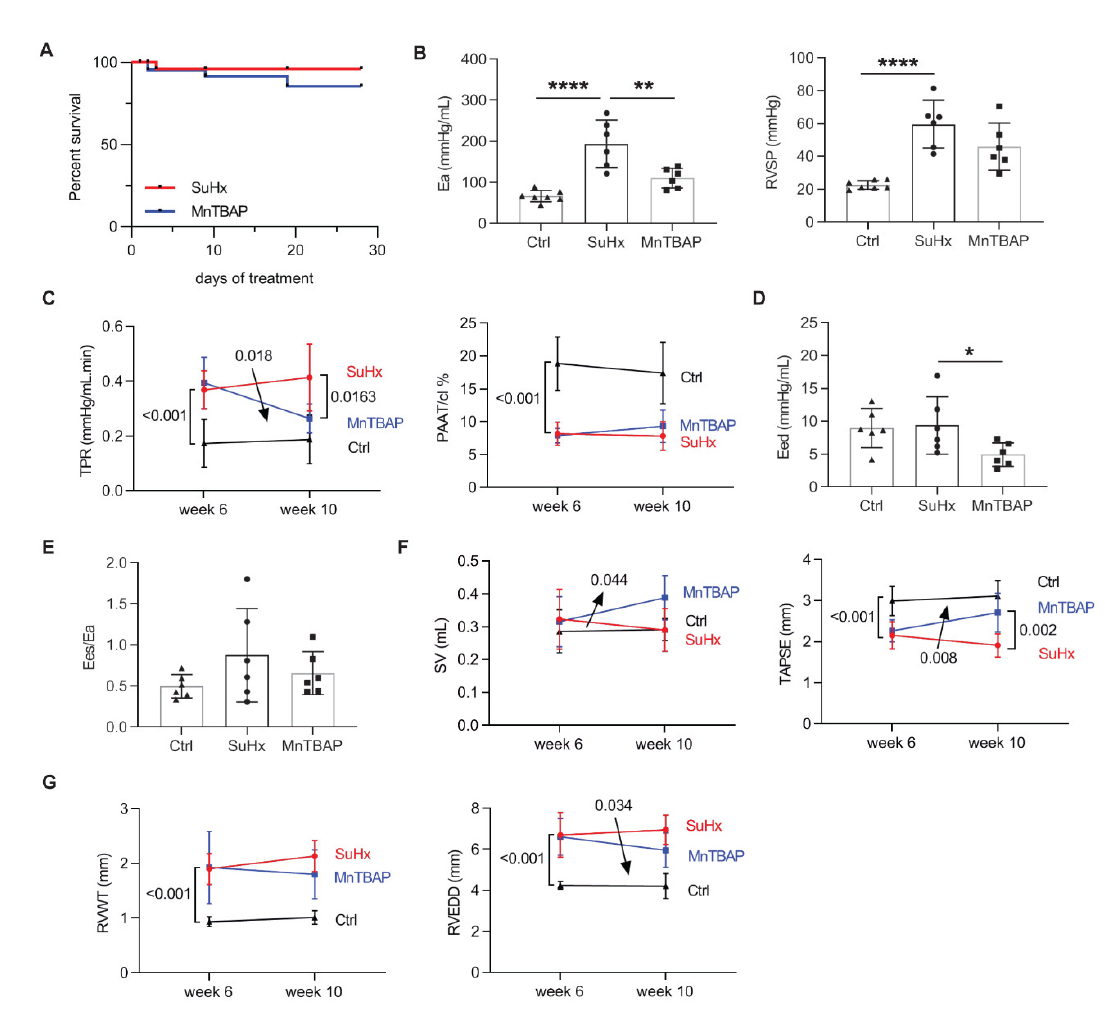
SV = stroke volume, TAPSE = tricuspid annular plane systolic excursion, RVWT = right ventricular wall thickness, RVEDD = right ventricular end diastolic diameter. MnTBAP reduced pulmonary vascular remodeling and oxidative stress in experimental